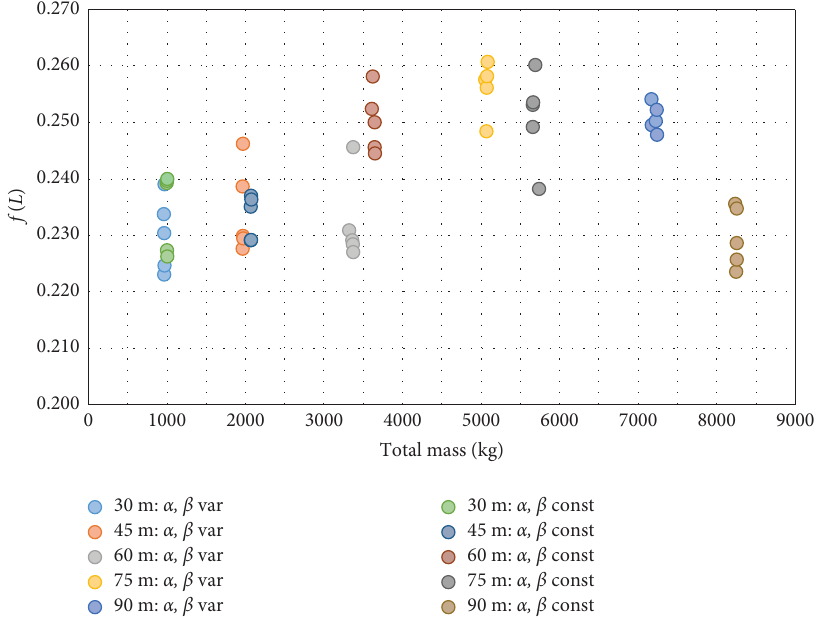
Figure 5: Five best values of ratio f / L at variable and constant angles α and β for all spans, and R ≥